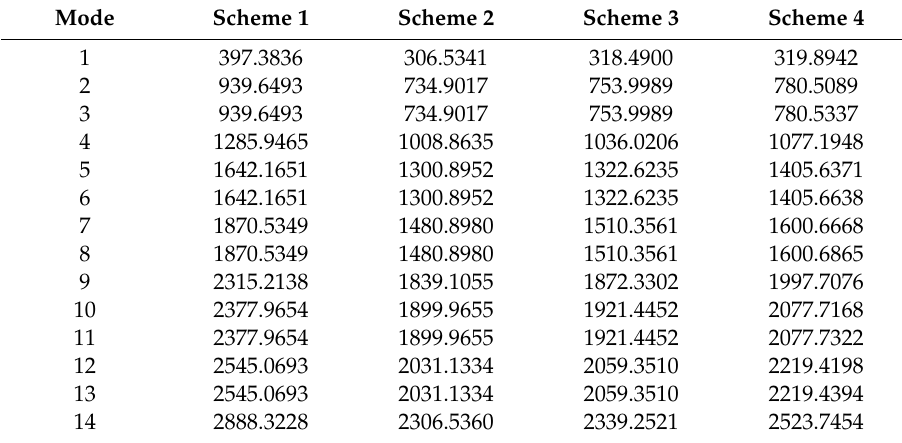
Table 7. First fourteen natural frequencies (Hz) of a simply-supported thick plate for several through-the- thickness distributions of the reinforcing